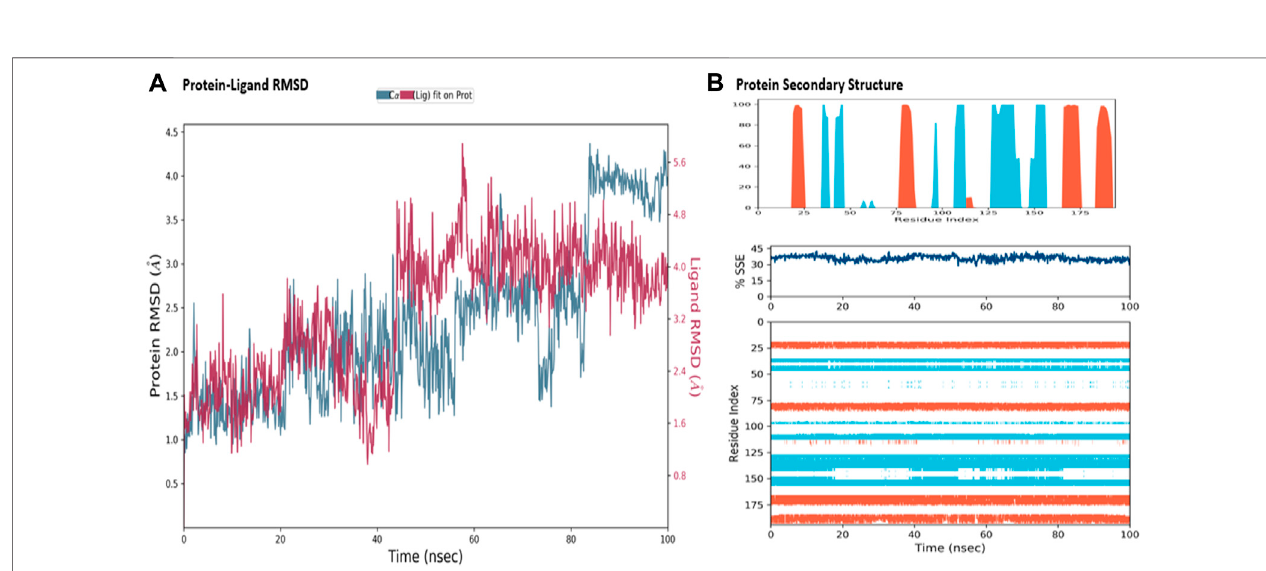
FIGURE 5 | Molecular dynamics simulation analysis of nytose. (A) The RMSD plot was obtained for compound Nystose complexed with SRA domain of E3 ubiquitin-protein ligase UHRF1(PDB: 3BI7). The 100 ns simulation time reaf fi rmed the stability of the complex without any signi fi cant changes in the structure. (B) Stability of the secondary structure UHRF1 over the 100 ns of MD simulation when complexed with Nystose. Protein secondary structure elements (SSE) like alpha- helices and beta-strands were monitored throughout the simulation. The top plot reported SSE distribution by residue index throughout the protein structure. The middle plot summarized the SSE composition for each trajectory frame throughout the simulation, and the plot at the bottom monitored each residue and its SSE assignment over time.